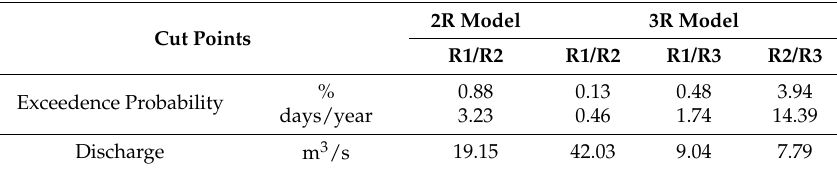
Table 5. Parameters of the models of three deposits.